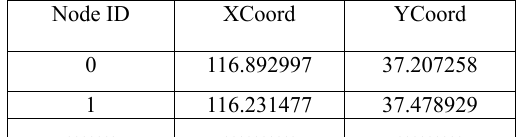
Figure 6. Real point matching